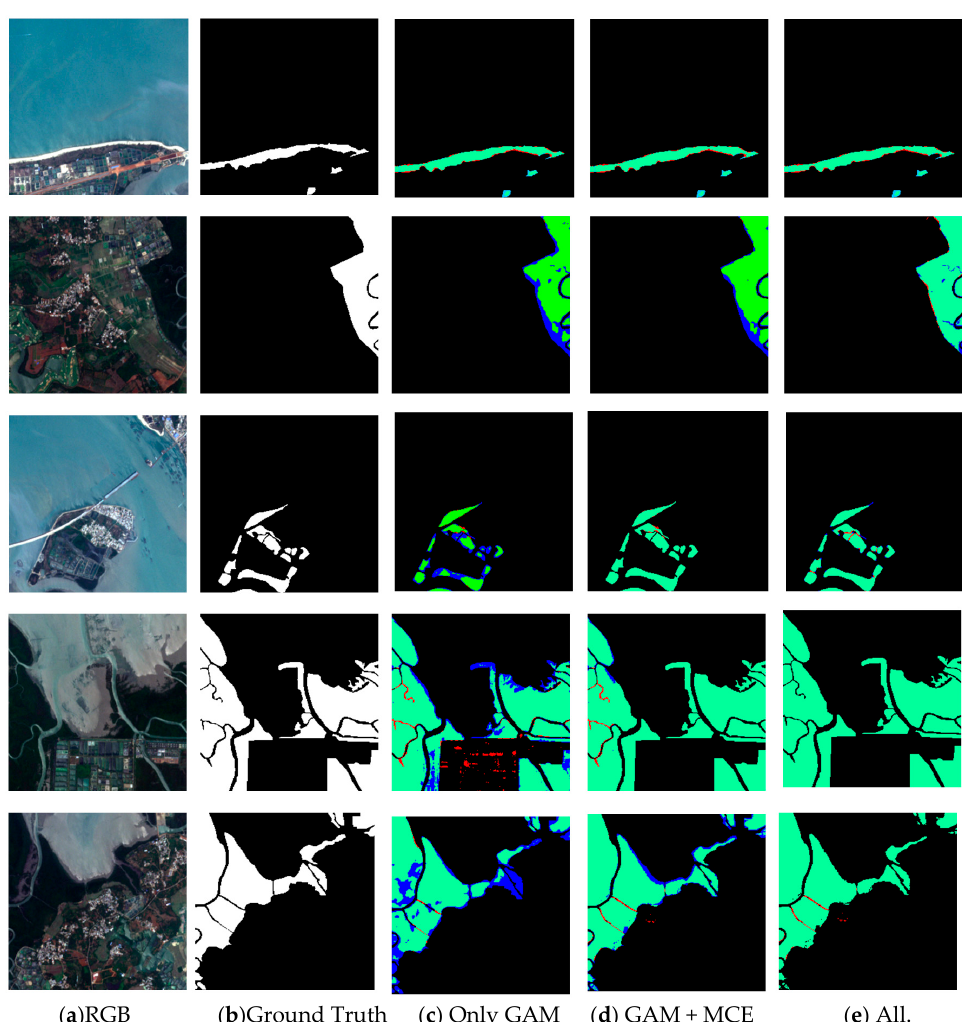
Figure 10. Results of mangrove extraction in different environments by different modules in ME-Net. The original images ( a ), the corresponding ground truth ( b ) and predictions ( c – e ) are presented. Green, red, blue, and black represent true positive (TP), false positive (FP), false negative (FN), and true negative (TN)